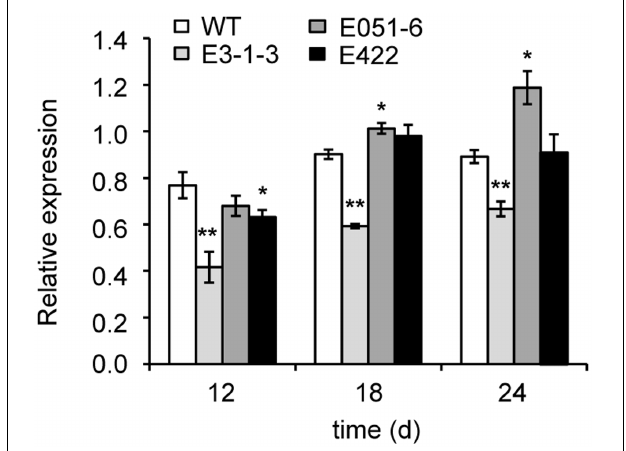
FIGURE 3 | Expression change of gene TaAGP.L-B1 in developing seeds. Fold change is normalized using the actin gene (GenBank accession no: AAW78915) as a control. Three mutated lines in the TaAGP.L-B1 gene were compared to the wild type wheat Jing411 . WT, wild type; ∗ , ∗∗ significantly different from WT at the P = 0.05, 0.01 level, respectively, based on the Student’s t -test.